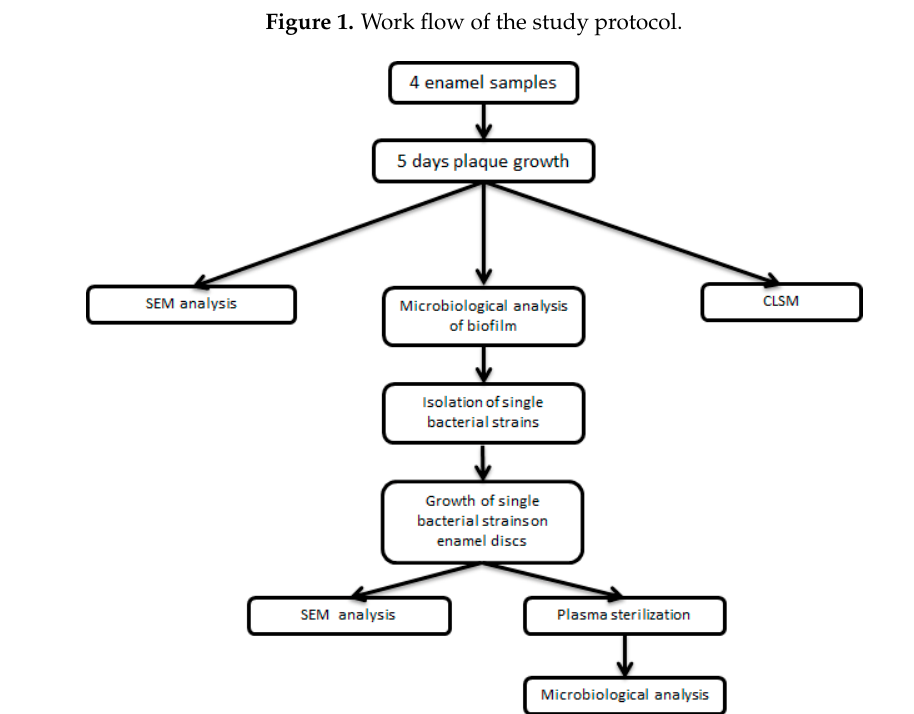
Figure 2. Work flow of the microbiological verification.